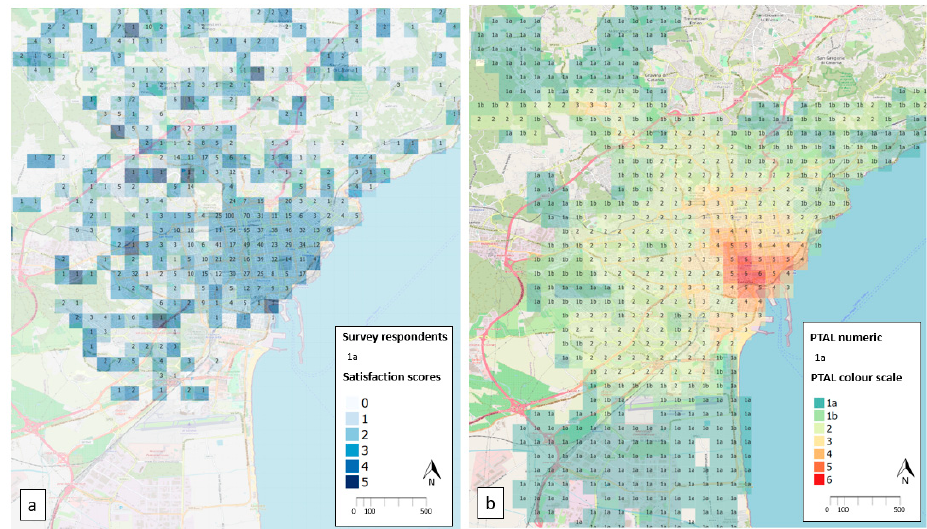
Figure 7. ( a ) Catania’s PTAL map; ( b ) satisfaction indicator map in comparison with PTAL values